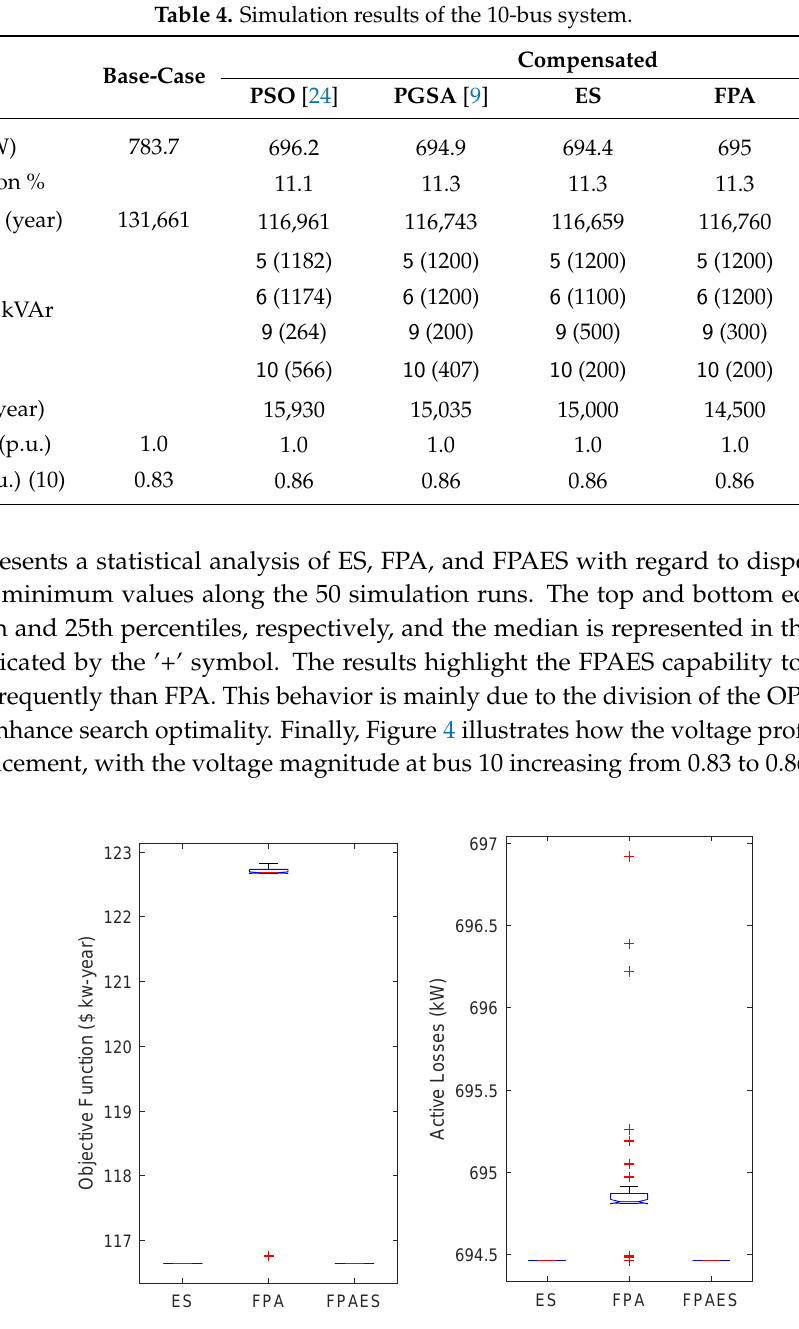
Figure 3. Box plot of 50 simulations, 10-bus system (the median is represented in the central mark, and the ’+’ symbol denotes the